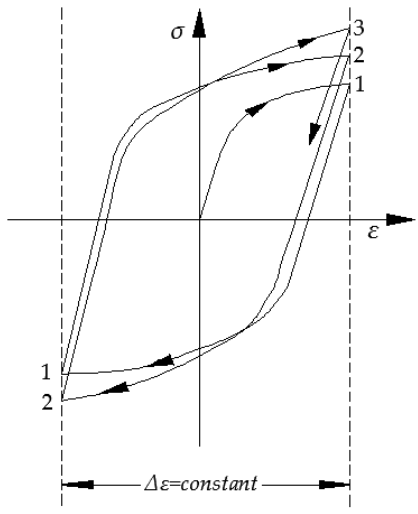
Figure 5. Cyclic behaviour of steel.